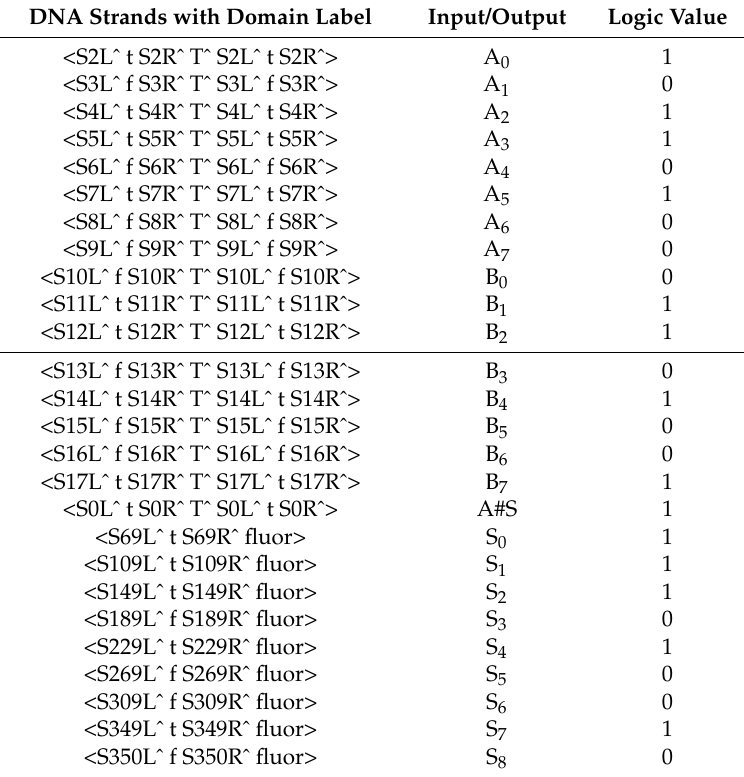
Table 3. Logic values of DNA signal strands (00101101 − 10010110 = 010010111). DNA Strands with Domain